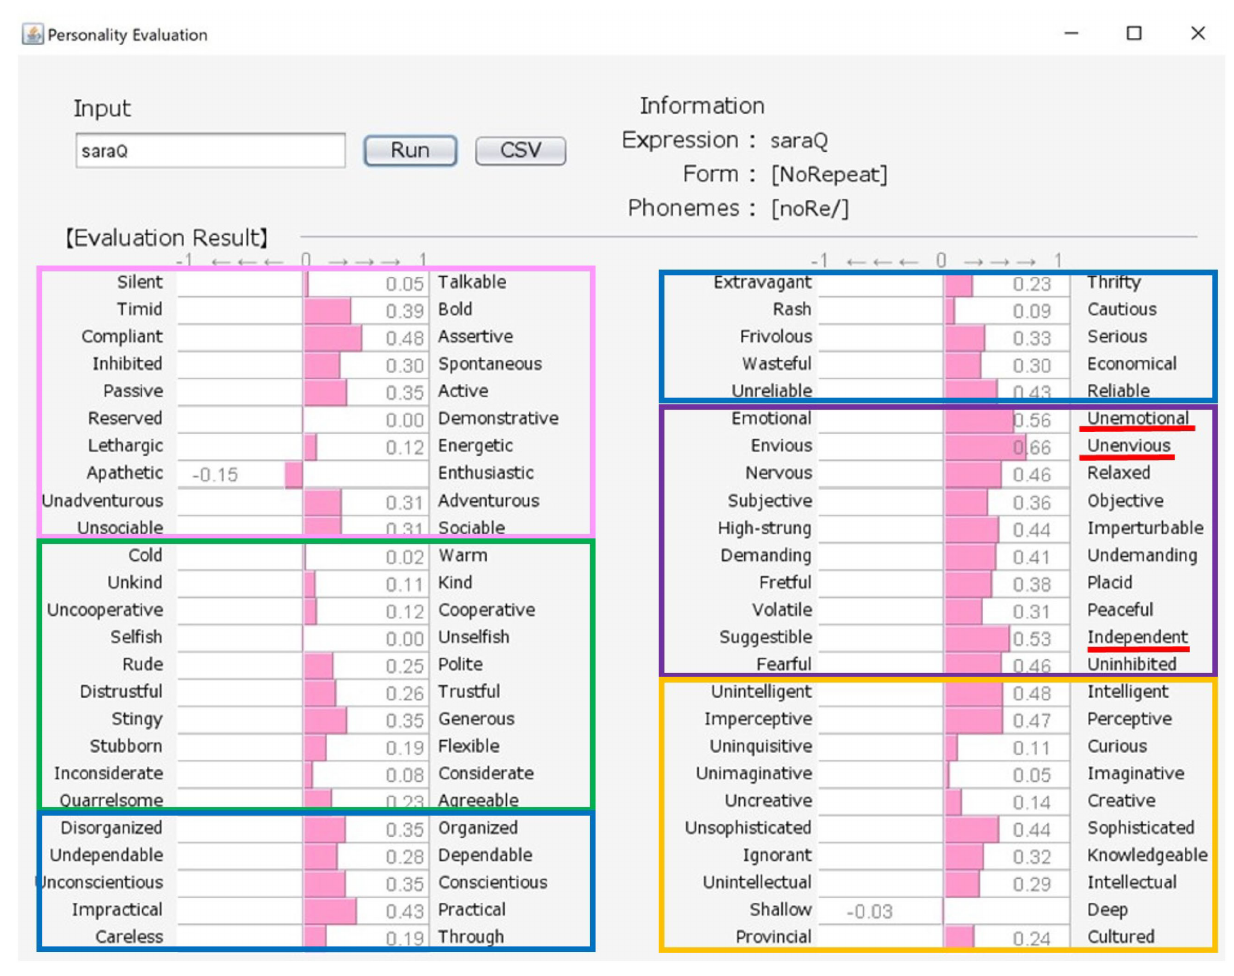
Frontiers in Psychology |